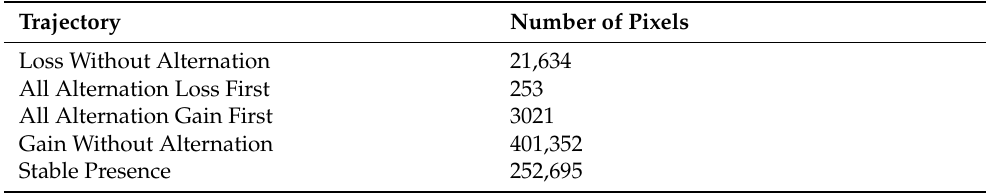
Figure 5. Trajectories of UIS in Accra and Kumasi ( a , b ) during the temporal extent. The pie charts show the segments of trajectories that constitutes each region’s unified region. Table 3. Sizes of trajectories that constitute the unified region in